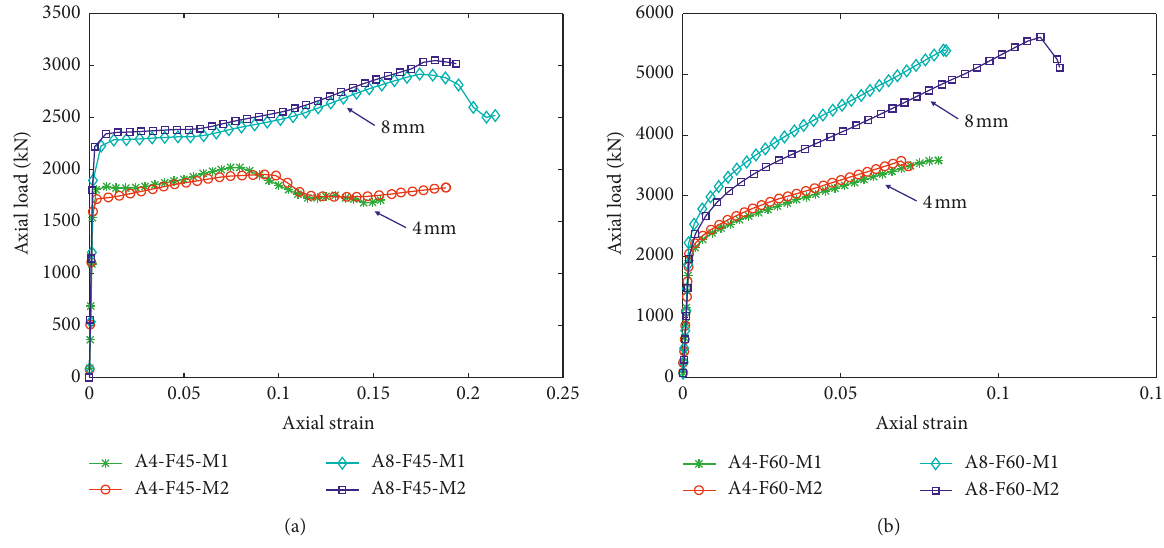
Figure 15: Effect of FRP tube thickness. (a) θ � ± 45 ° ; Type A steel tube. (b) θ � ± 60 ° ; Type A steel